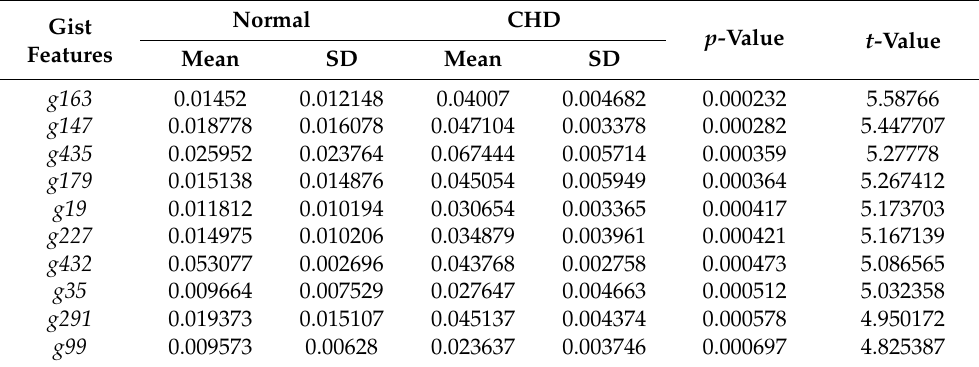
Table 4. Mean and standard deviation (SD) of ranked gist